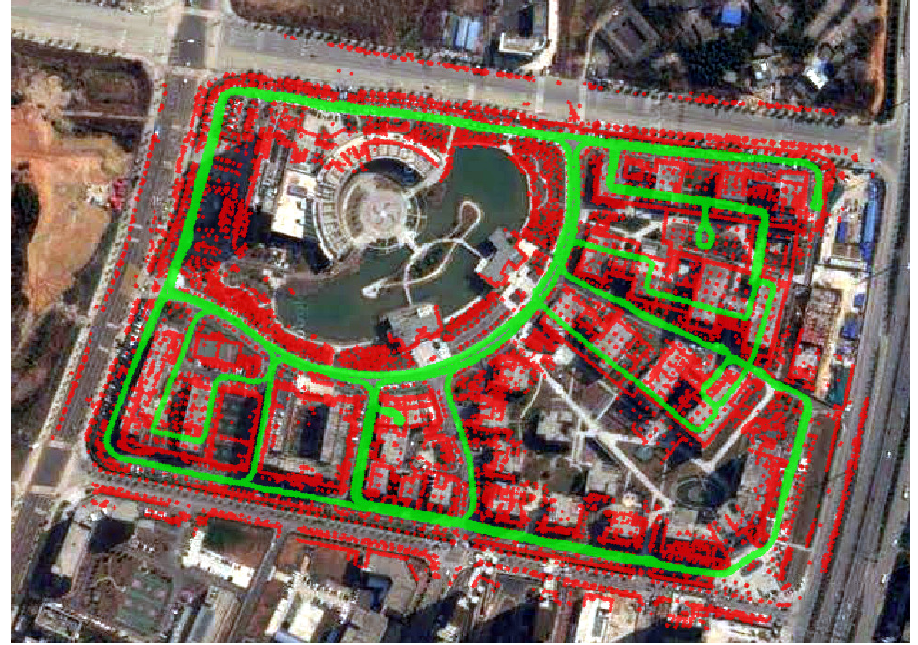
Figure 12. Mapping of the Zhongdian Science and Technology Park.